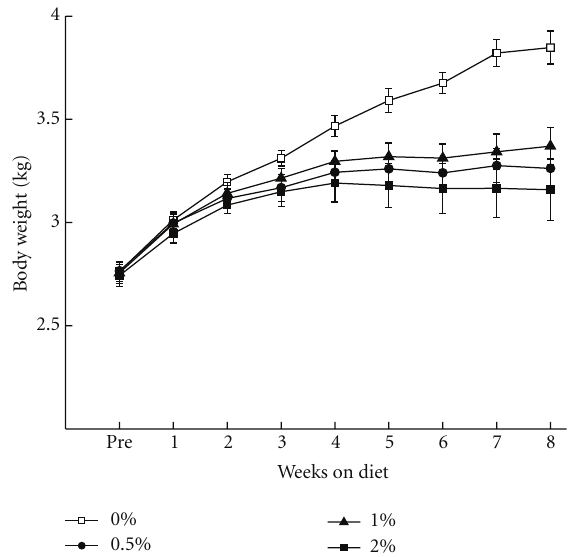
Figure 1: Mean ( ± SEM) body weight for rabbits in the 0%, 0.5%, 1%, and 2% cholesterol groups upon arrival (Pre) and across the eight weeks of the cholesterol diet.